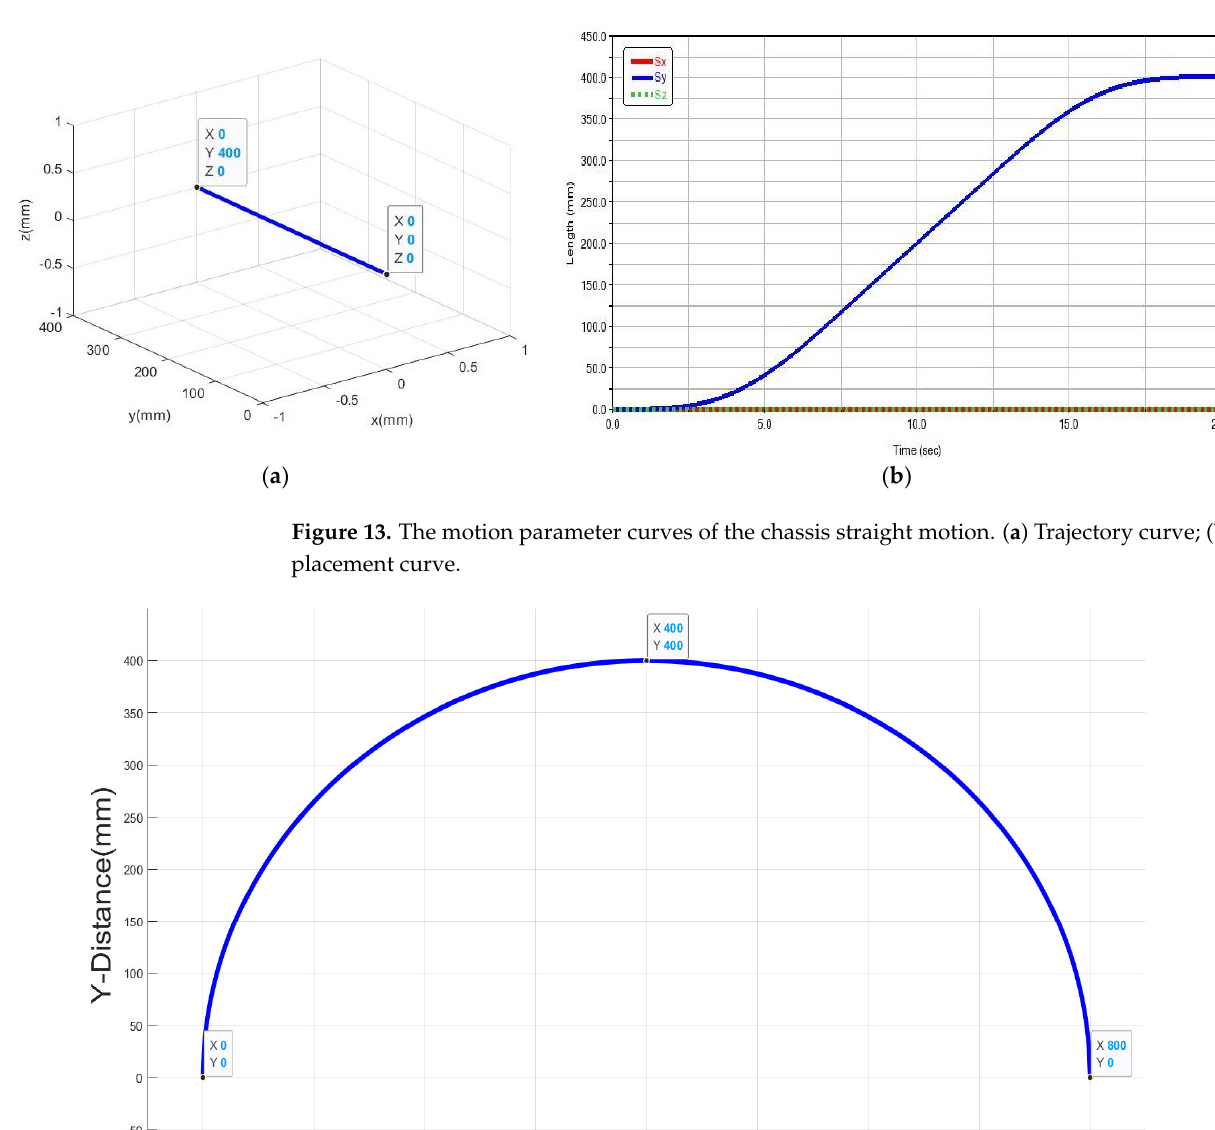
Figure 13. The motion parameter curves of the chassis straight motion. ( a ) Trajectory curve; ( b ) dis- placement curve.